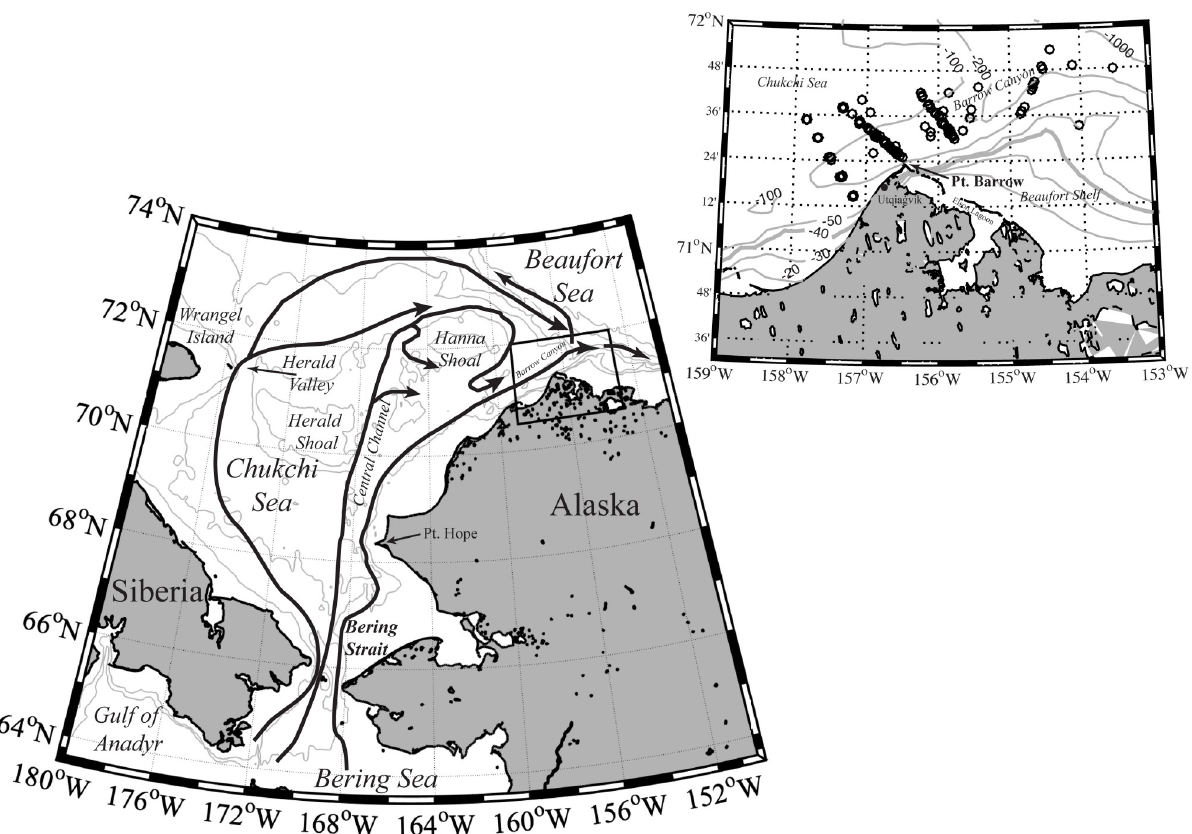
Fig 1. Geographic setting and dominant pathways of northward flow from the Bering Sea through the Chukchi Sea to Pt. Barrow, AK. Inset shows sampling locations near Pt. Barrow. Pathways of currents after Brugler et al . [19] and Danielson et al . [21]; not all currents are shown. Box indicates area enlarged in right panel. Many locations were sampled more than once and thus overlie each other. The 40-m isobath is denoted by the thicker gray line. Maps generated using Matlab/vR2016b.